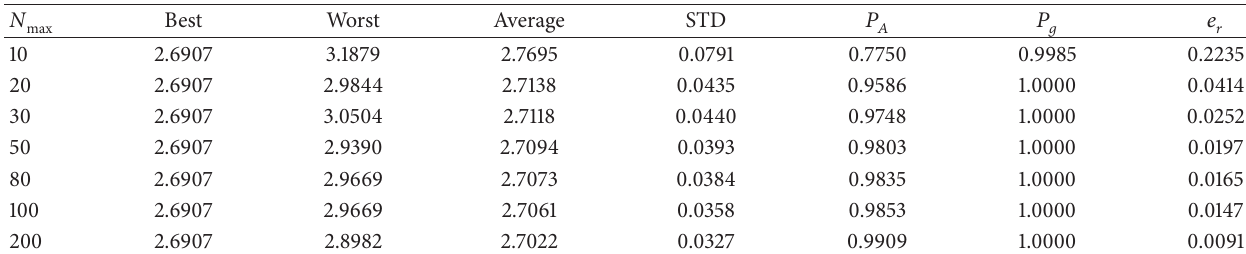
Table 2: Experimental comparison for maximum iteration number.